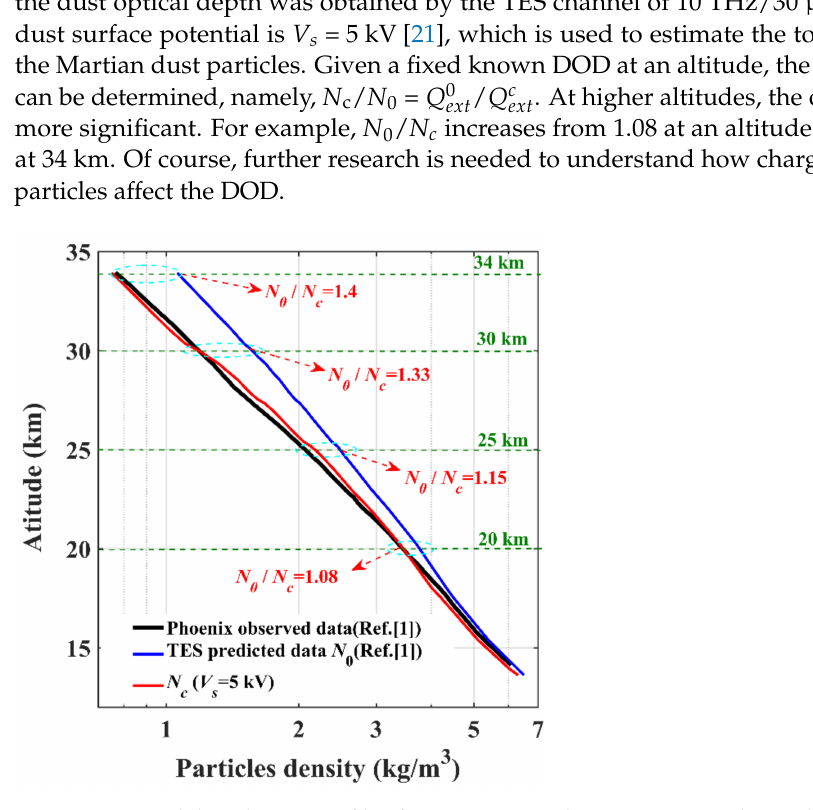
Figure 9. Vertical dust density profile of Martian atmosphere. Here, N 0 is the model prediction based on TES dust optical depth, given by ref. [1]. N c denotes the corrected vertical profile of dust particle density, by counting in the contribution of the particles’ net charges. The line in black is the observed data of Phoenix (see ref.